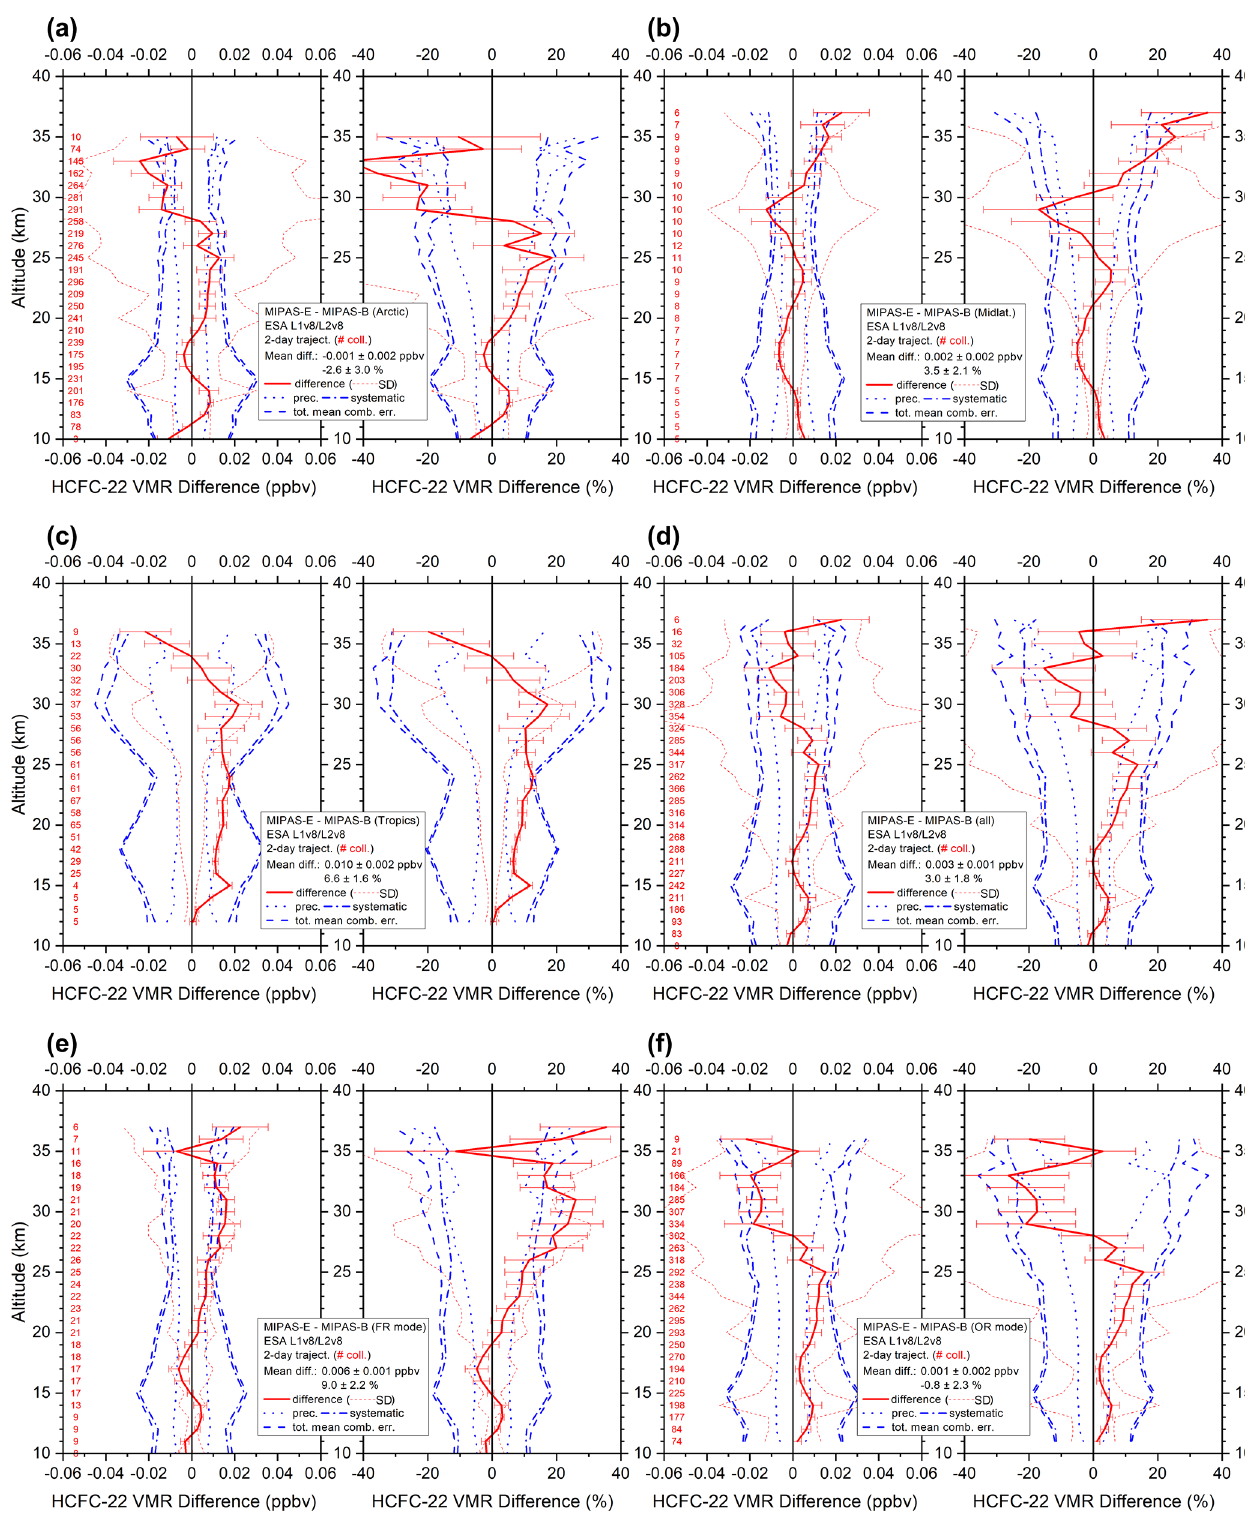
Figure 13. Same as Fig. 3 but for